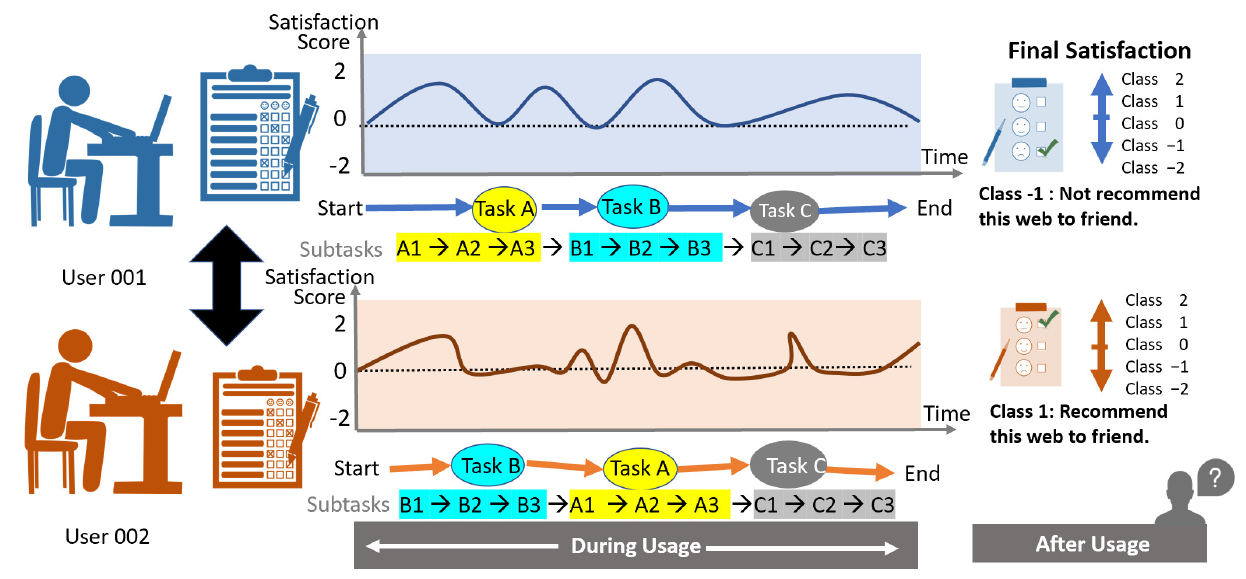
Figure 11. Example of a UX curve based on randomly ordered tasks.